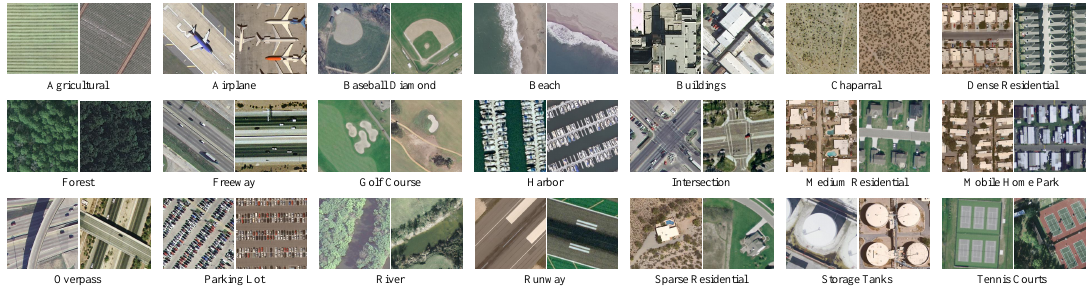
Figure 7. Two examples of each scene category in the UC Merced